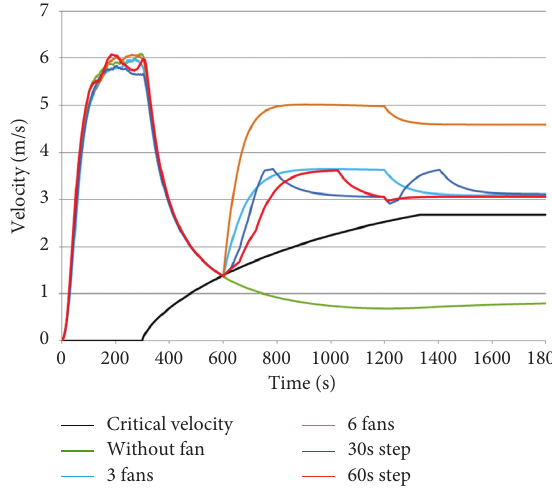
Figure 9: Comparison of algorithms of ventilation control for 50MW